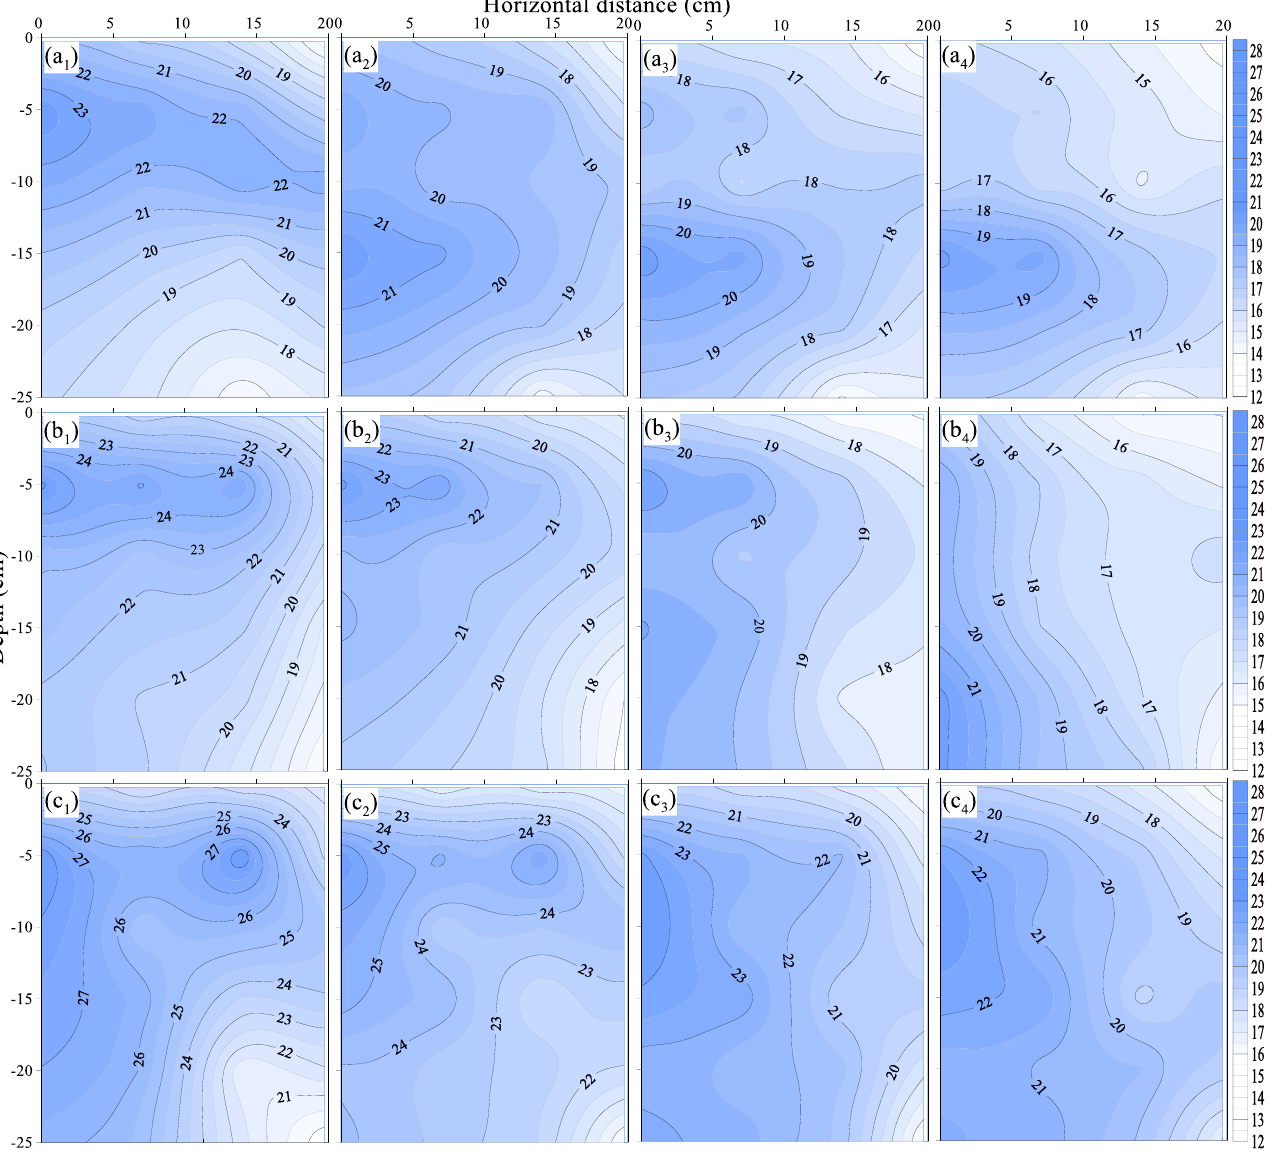
Figure 4. Soil moisture distribution under SDI 5 + N 240 treatment. Latter a, b, and c represent first, second, and third irrigation events. The subscript numbers 1–4 denote sampling times of soil moisture subsequent to each irrigation.